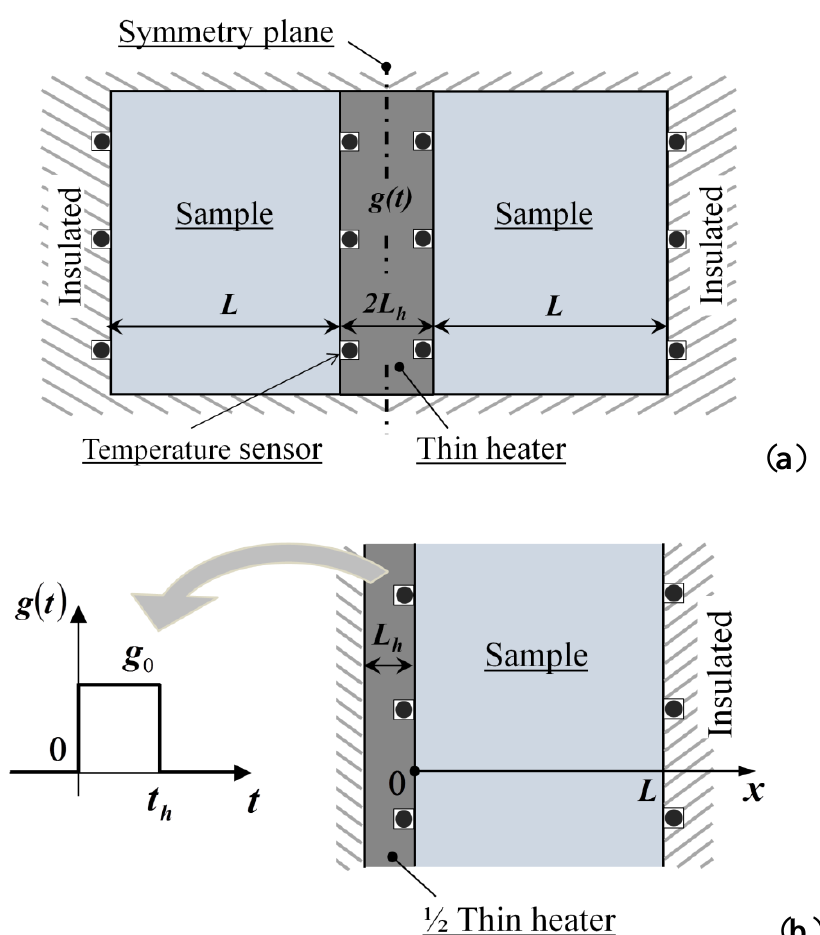
Figure 15. Plane source method: ( a ) schematic of the experimental apparatus, ( b ) two-layer con-